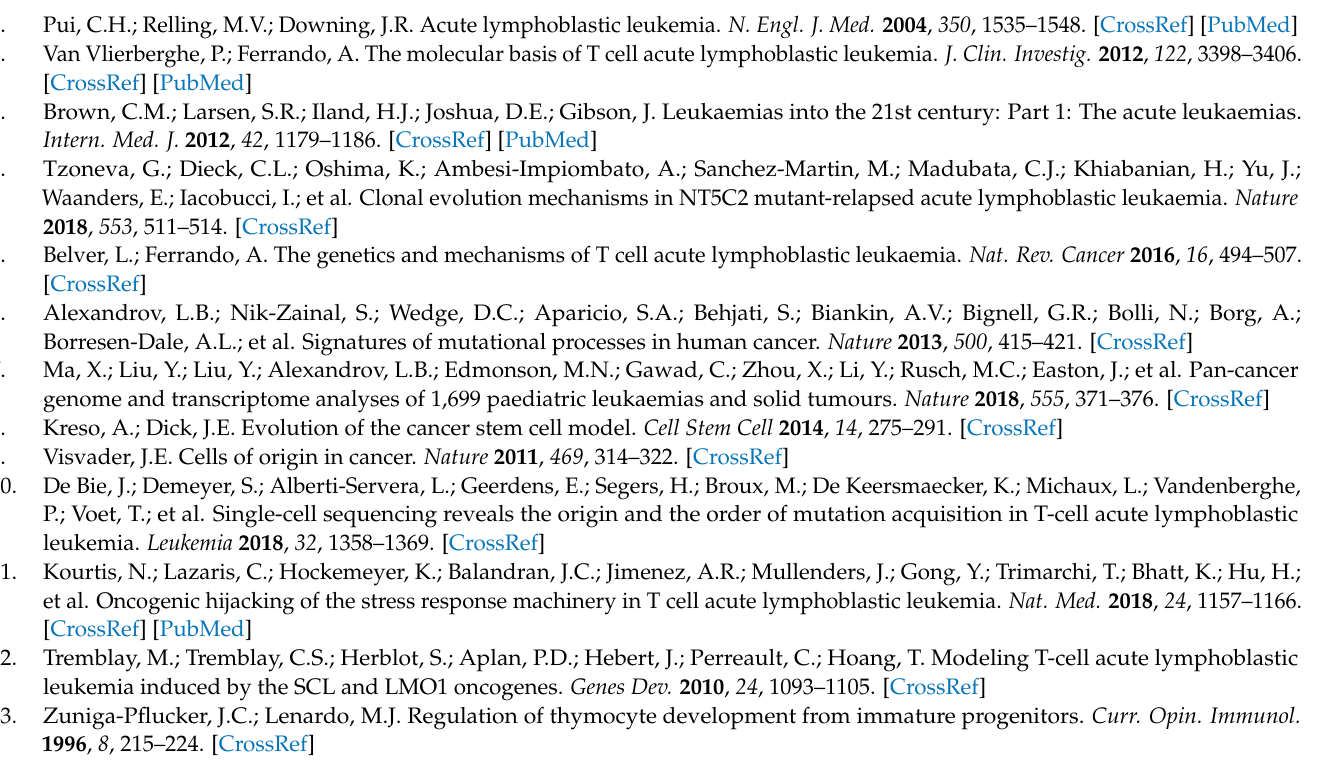
Supplementary Figure S2: Reduced expression of CD27 in mature DN thymocytes of IL-15-deficient NOD. Scid mice; Supplementary Figure S3: Increased NOTCH1 activation in cell lines established from NOD. Scid.Il15 − / − mice; Supplementary Figure S4: Expression of leukemia-associated genes in primary leukemic cells isolated from NOD. Scid.Il15 − / − mice; Supplementary Figure S5: Original Western blots for Figure 5; Supplementary Figure S6: Original Western blots for Figure